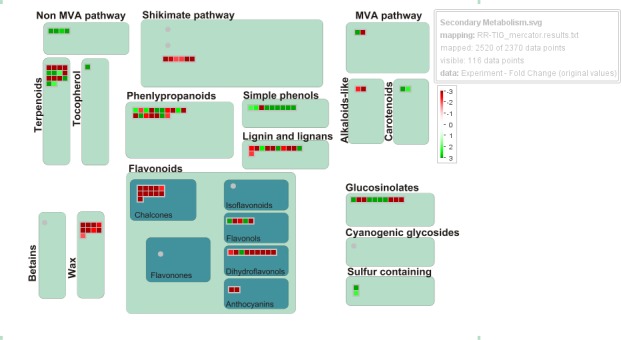
MapMan-based visualization of the DEGs involved in “secondary metabolism”.In the display, each BIN or subBIN is represented as a block where each transcript is displayed as a square, which is either colored red if this transcript is up-regulated in RR or green if this transcript is up-regulated in TIG.